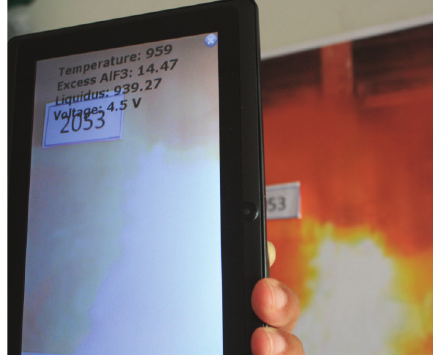
Figure 7: Augmented view of cell 2053 with superimposed information for four process variables.